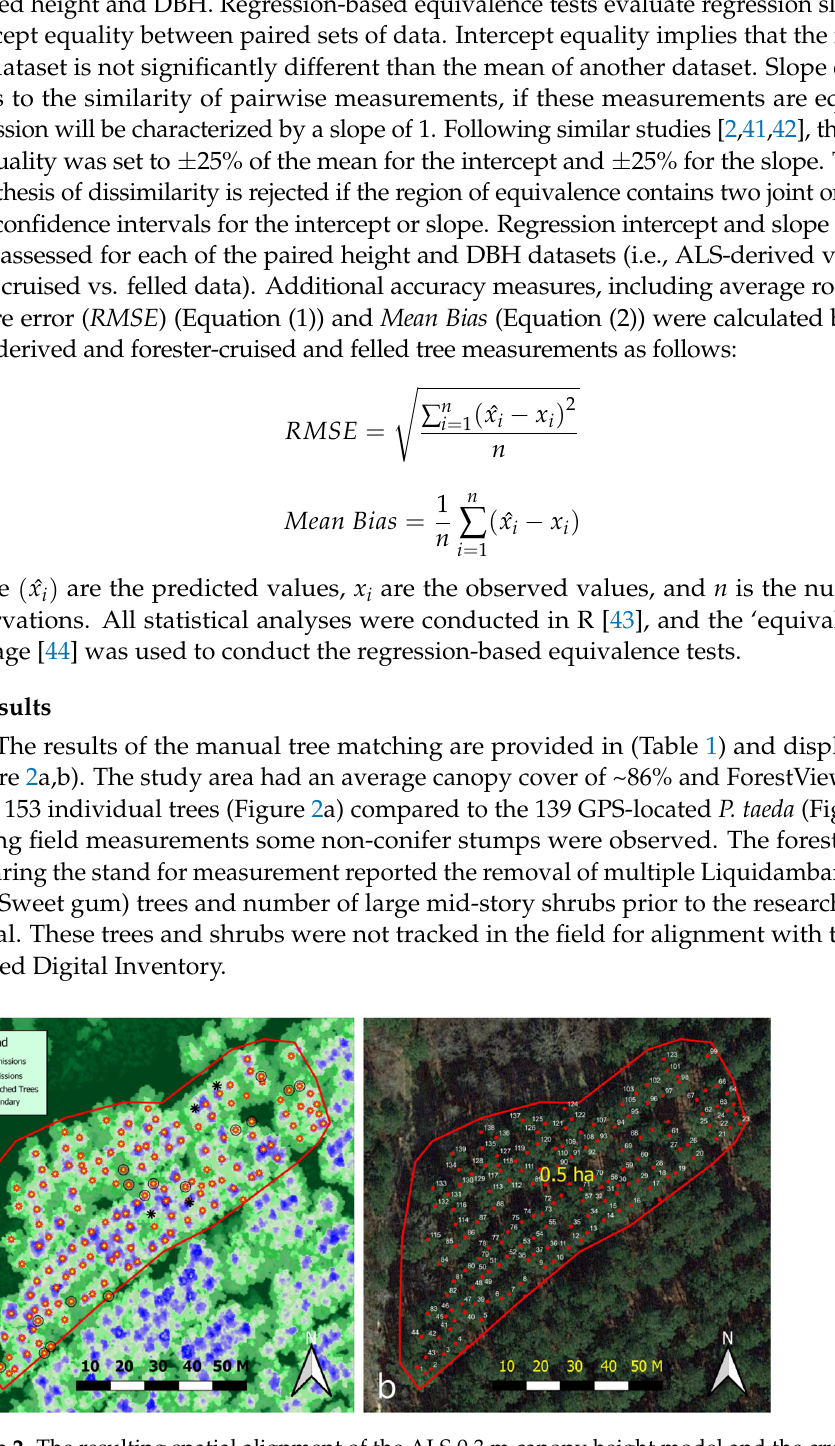
Figure 2. The resulting spatial alignment of the ALS 0.3m canopy height model and the cruised and felled tree data. ( a ) There were 153 trees identified by ForestView ® , three trees were not detected (omission error), and 15 extra trees were identified by ForestView ® (commission error). ALS commission errors were assumed to be attributable to a mix of deciduous tree species and mid-canopy shrubs mechanically removed from the site prior to field measurements. ( b ) There were 139 loblolly pine ( P. taeda ) trees field-mapped (cruised) and mechanically felled within the study area. The sequentially numbered individual tree labels are provided for reference.